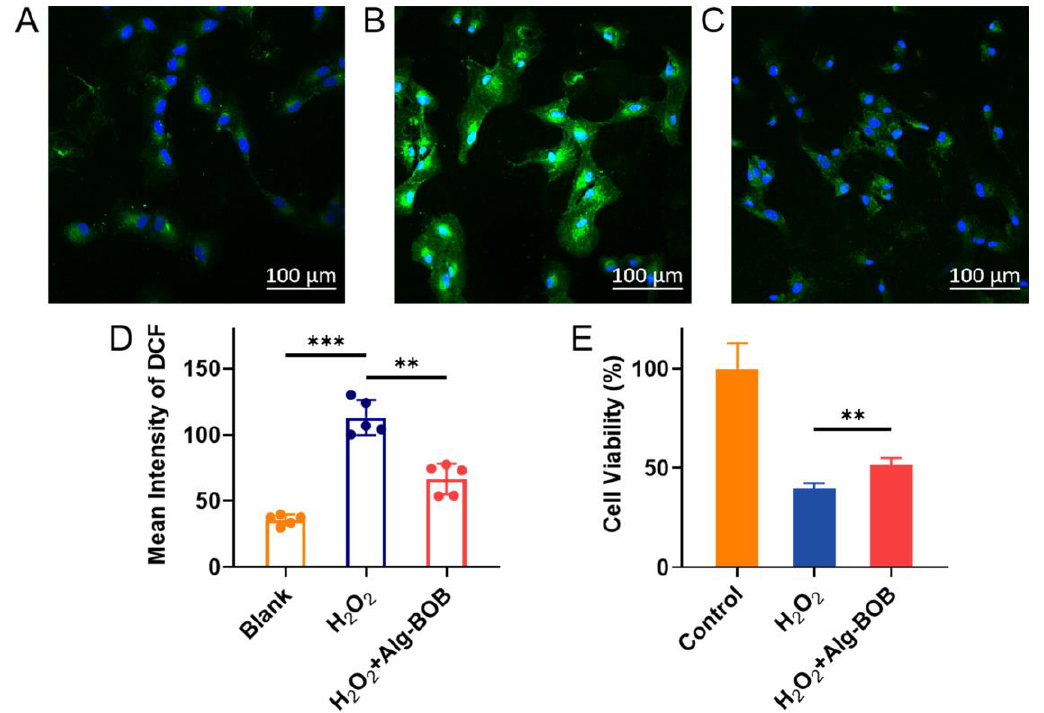
Figure 6. Fluorescence microscopy images showing the intracellular ROS levels of ( A ) Negative control with only culture medium, ( B ) Positive control (H 2 O 2 stimulated for 4 h), and ( C ) Alg-BOB hydrogel co-incubated group with H 2 O 2 treatment for 4 h. ( D ) Quantitative analysis of average DCF fluorescence intensity in each group ( n = 5). ( E ) Cell viability of ARPE-19 cells post H 2 O 2 treatment for 4 h with or without Alg-BOB hydrogel co-incubation ( n = 5). Data represent mean ± SD, ** for p < 0.01 and *** for p < 0.005.